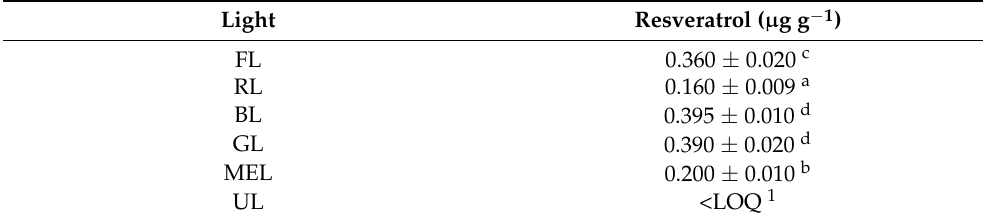
Table 1. Quantitative analyses of resveratrol contents in the peanut sprouts grown under the different light qualities.